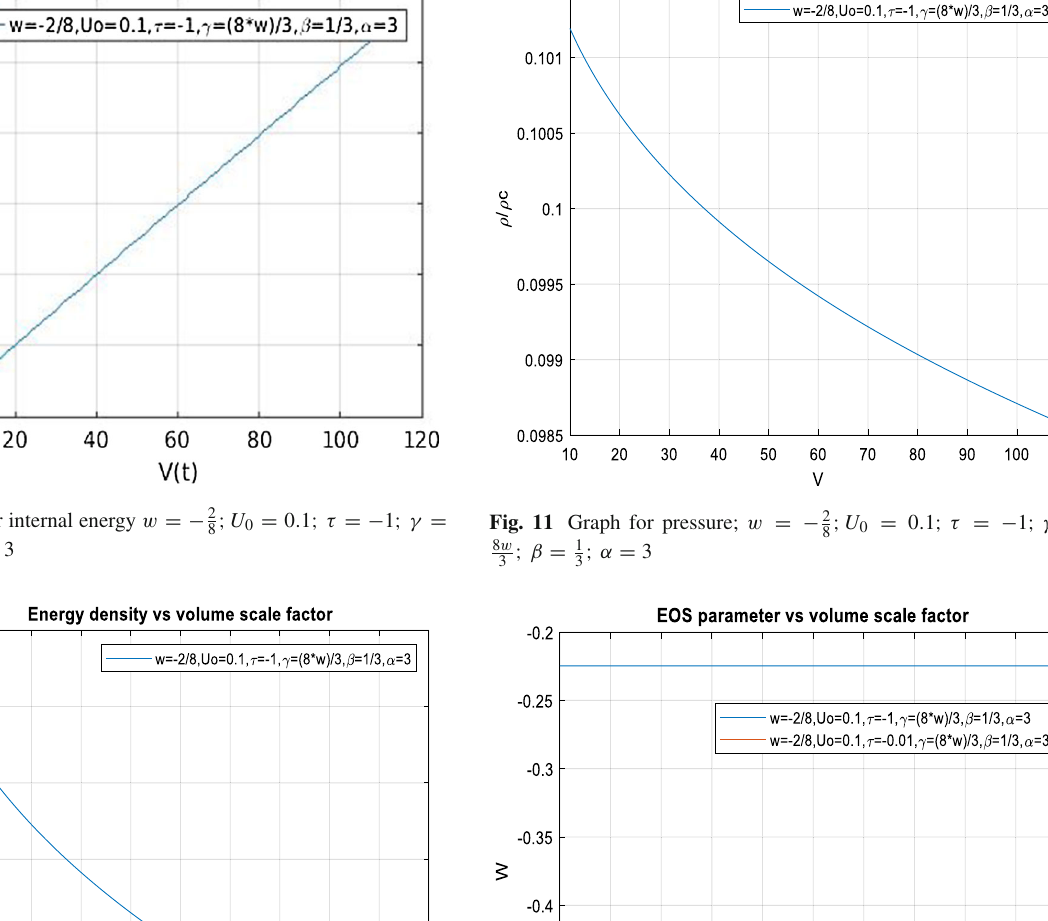
Fig. 10 Graph for energy density; w = − 2 8 w ; β = 1 ; α = 3 3 3